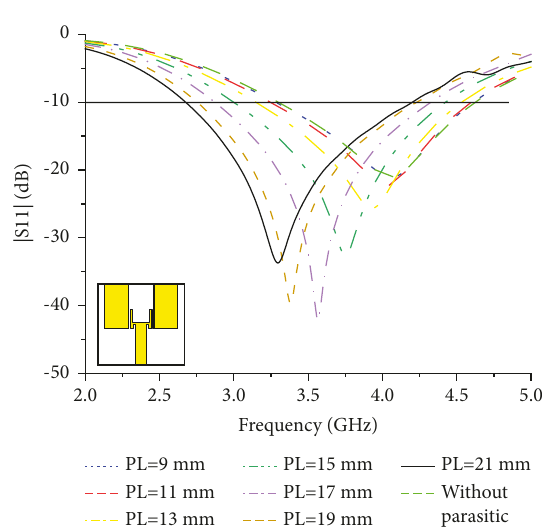
Figure 3: Variation of the reflection coefficient for different length of parasitic element on the ground plane ( P L ).